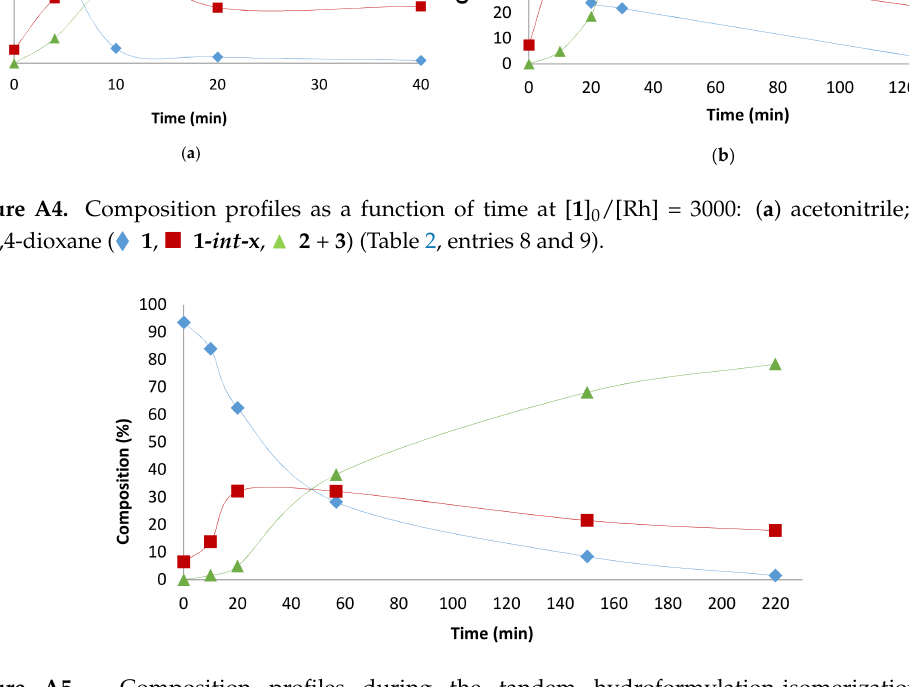
Figure A5. Composition profiles during the tandem hydroformylation-isomerization of 10-undecenitrile with Rh-biphephos in toluene at [ 1 ] 0 /[Rh] = 3000 at 30 bar CO + 10 bar H 2 ( (cid:7) 1 , (cid:4) 1- int -x , (cid:78) 2 + 3 ) (Table 3, entry 14).